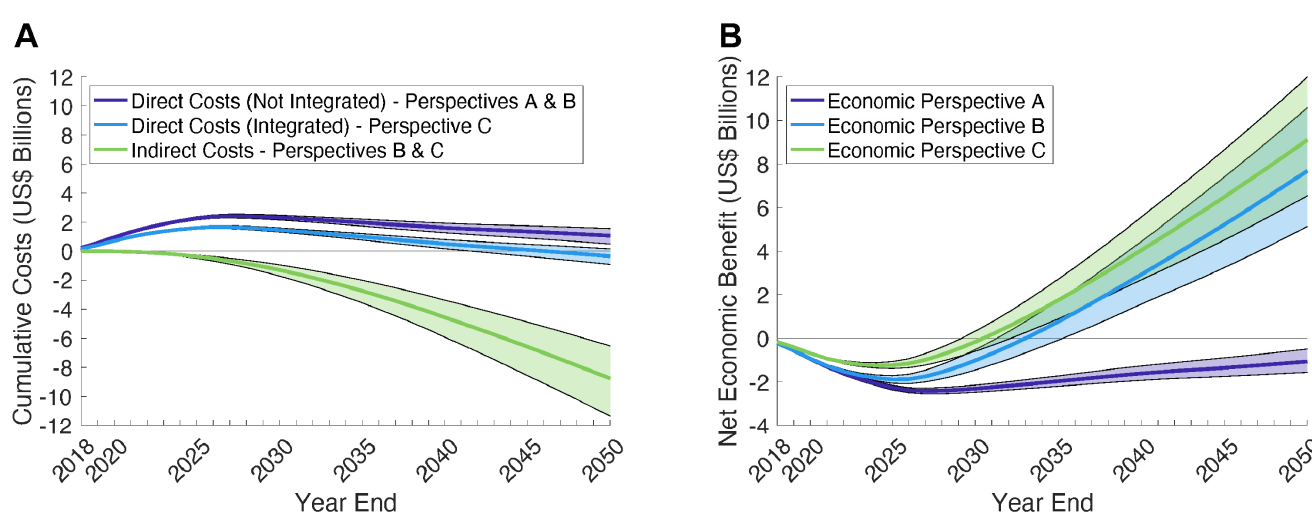
Fig 2. (A) Estimated cumulative direct costs and indirect costs of EL versus SQ. (B) Net economic benefit of EL versus SQ including direct and indirect costs. For the net economic benefit of EL, 3 economic perspectives were used: Perspective A–Direct costs only with no integration of testing. Perspective B–Direct costs (no integration of testing) and productivity gains. Perspective C–Partially integrated direct costs and productivity gains. All costs are in 2018 US$ and discounted at 3.5% per annum; healthcare costs were applied to all liver disease states pre- and post-cure; staffing costs were applied to all testing and treatment interactions; one-third of initial screening was assumed to not incur staffing costs and had reduced HCV RNA testing kit cost in the EL scenario with economic perspective C. The solid line and shading indicate the median and 95% UIs across 1,151 model fits. EL, elimination; HCV, hepatitis C virus; SQ, status quo; UI, uncertainty